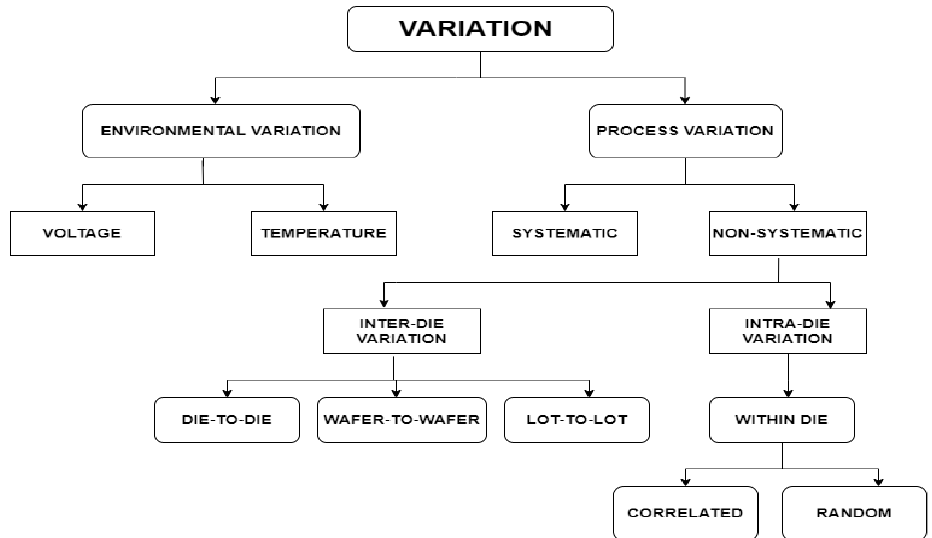
Figure 2. Different kinds of variations.